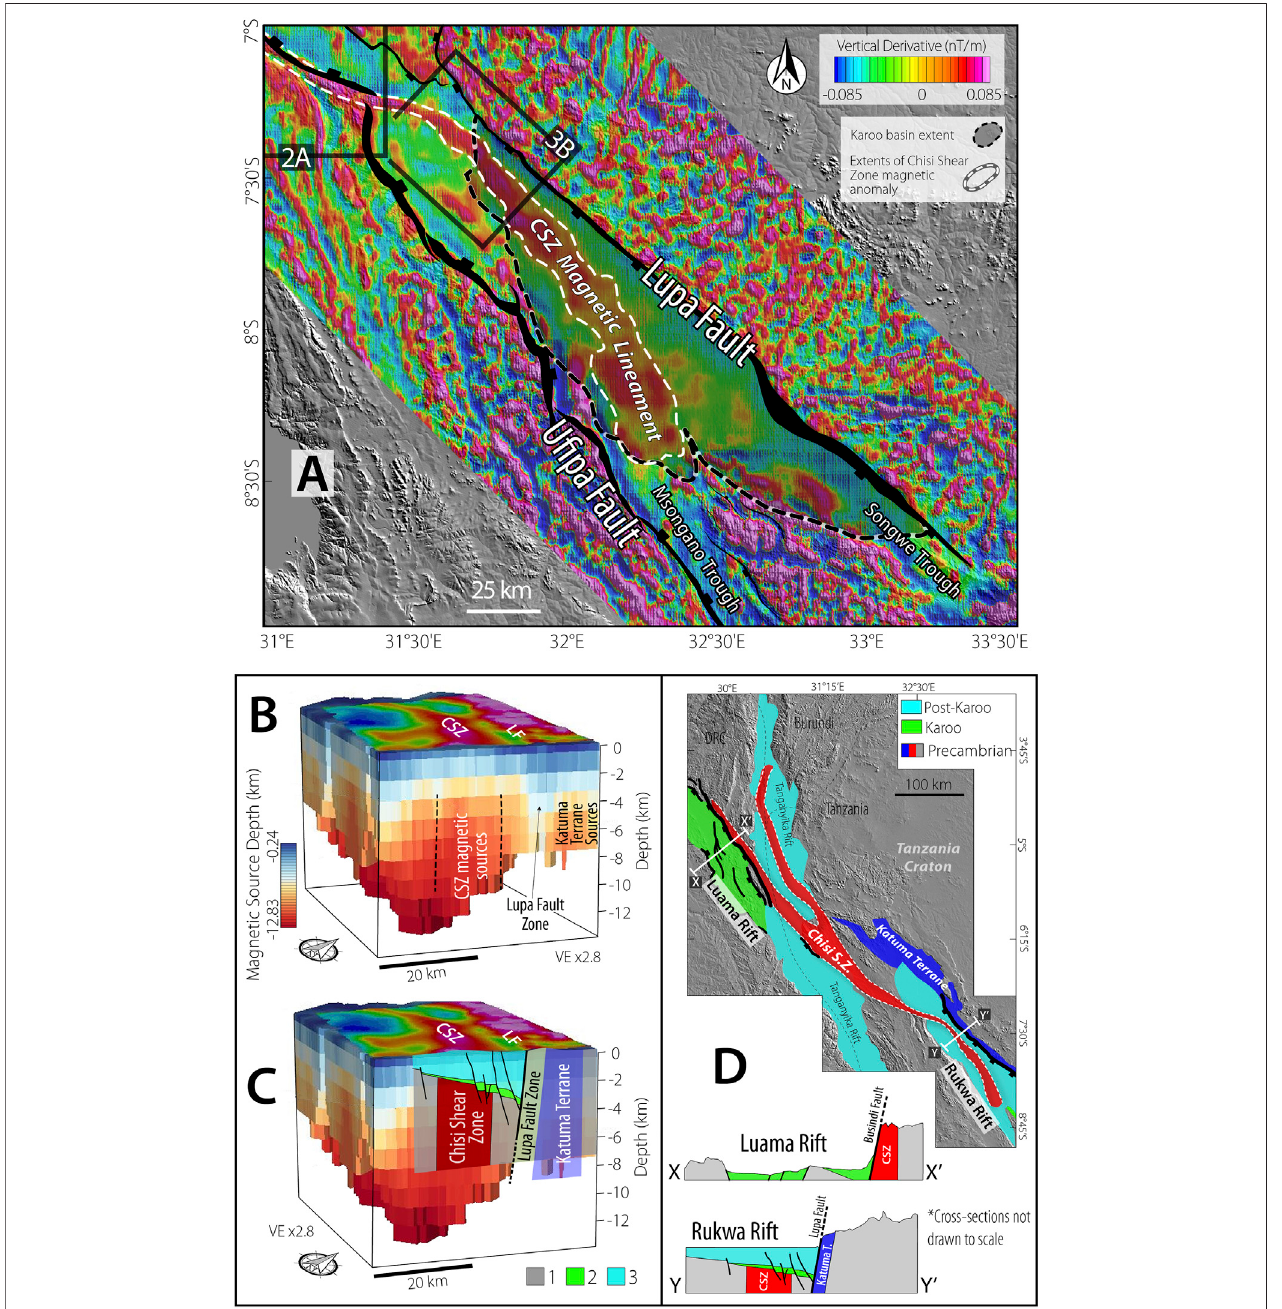
FIGURE 3 | (A) : Vertical derivative of the aeromagnetic grid overlaid on satellite Digital Elevation Model (DEM) hillshade map, showing the rift border faults, rift shoulder basementfabricsandtheaeromagneticsignatureoftheChisiShearZone(CSZ)alongtheriftaxis.Seeuninterpretedaeromagneticmapsin SupplementaryFigure1 . (B) :3-D gridded block of the Source Parameter Imaging (SPI) solutions from the transform of the aeromagnetic grid, showing the subsurface extents and geometry of CSZ and the shallower Katuma Terrane magnetic sources. (C) : 3-D gridded block overlaid with interpretations of the rift faults and simpli fi ed stratigraphy (interpretations from 2-D seismiclineTXZ-16ofMorleyetal.,1999shownin Figure2C ).Stratigraphicunitsshown:1 (cid:1) Precambrianbasement),2 (cid:1) Permo-Triassic(KarooGrp.)sequences,3 (cid:1) Post- Karoosequencesi.e.,RedBedGrp.andLakeBedFm.). (D): RegionalsatelliteDEMhillshademapshowingthe > 600 kmextentoftheCSZanditsrelationshipswiththeRukwa and Luama segments of the Rukwa Trend. The Luama Rift cross-section is based on legacy geologic maps and satellite DEM, and that of the Rukwa Rift is based on 2-D seismic data interpretation, satellite DEM, and aeromagnetics.